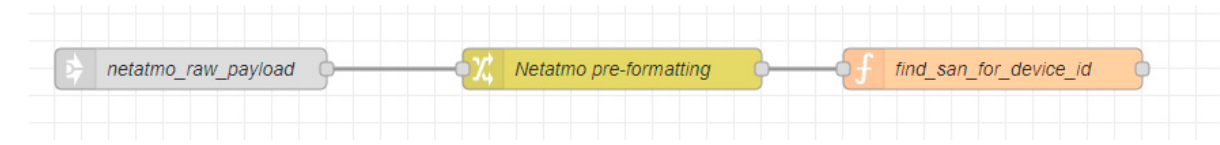
Figure 7. Node-RED flow—Payload sanitizing of Netatmo weather station.